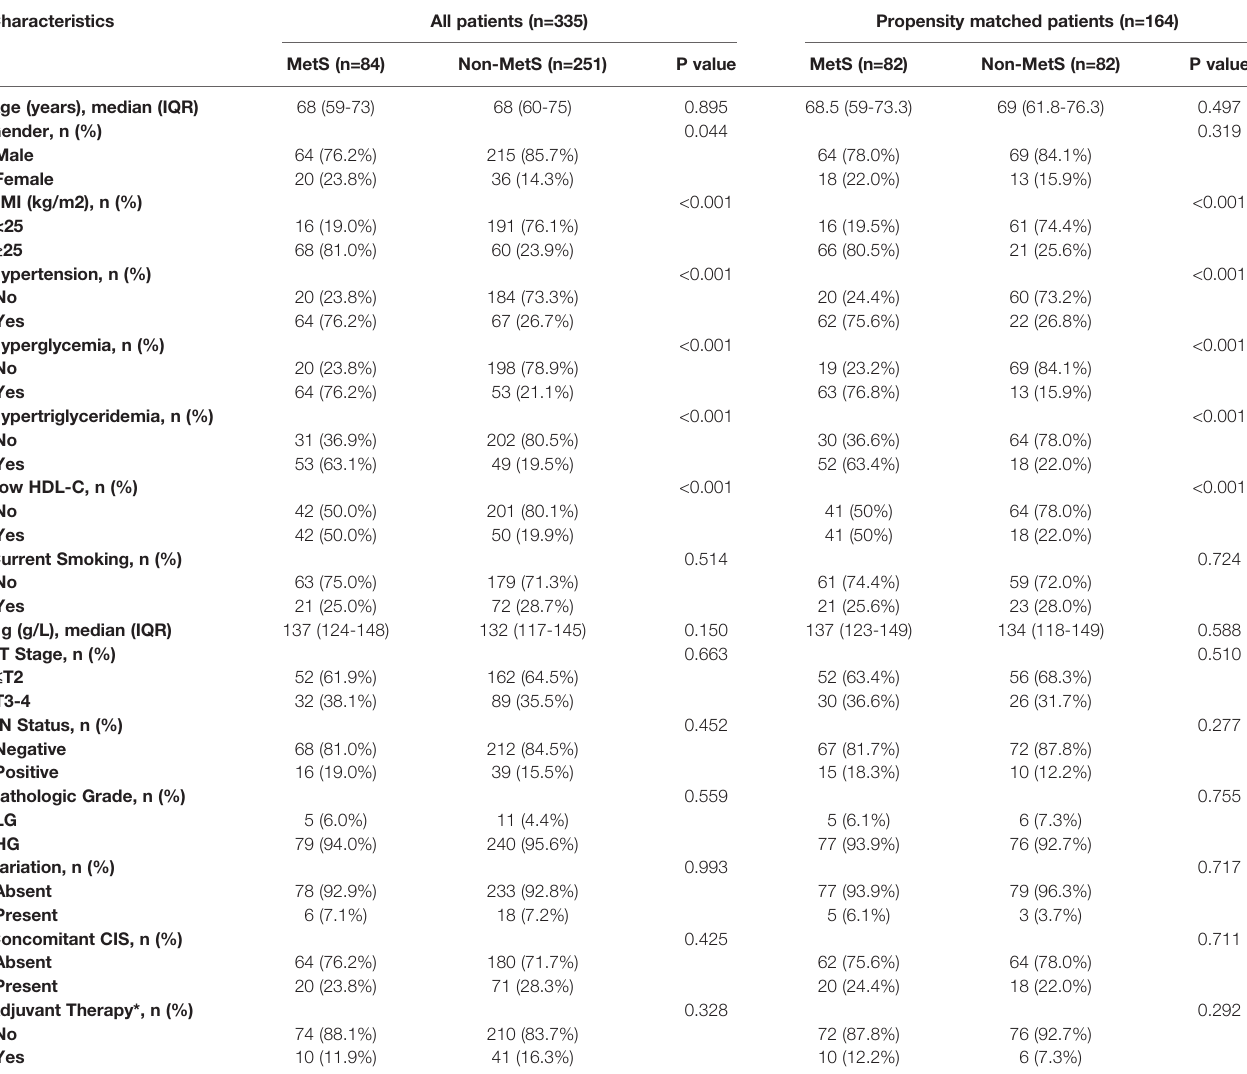
TABLE 1 | Clinicopathological characteristics of the all patients and propensity matched patients. Characteristics All patients